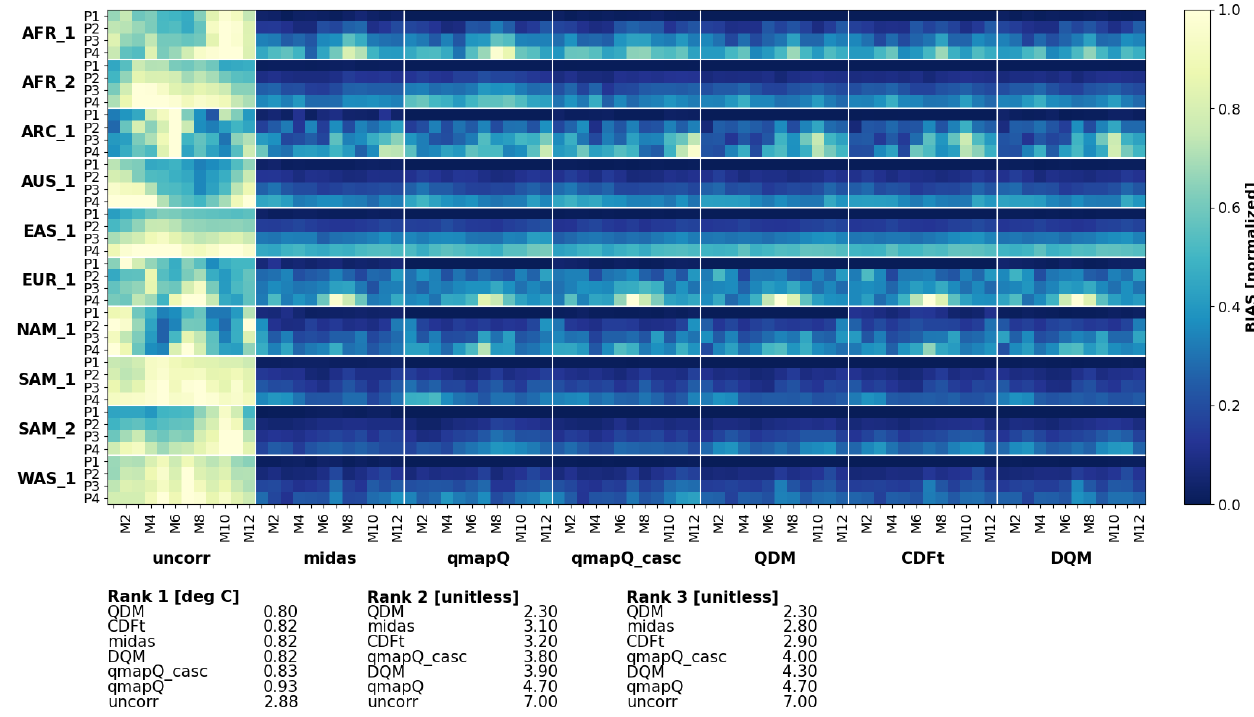
Figure 8. The same as Fig. 6 but for mean temperature.